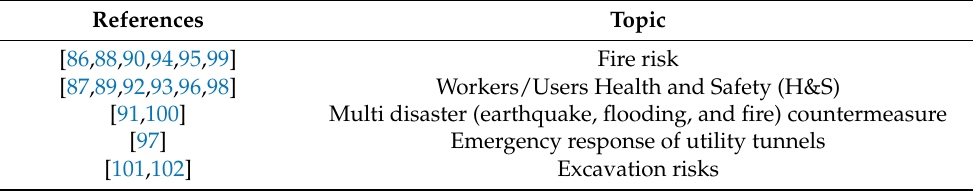
Table 10. Risk management core competence: articles grouped by topic